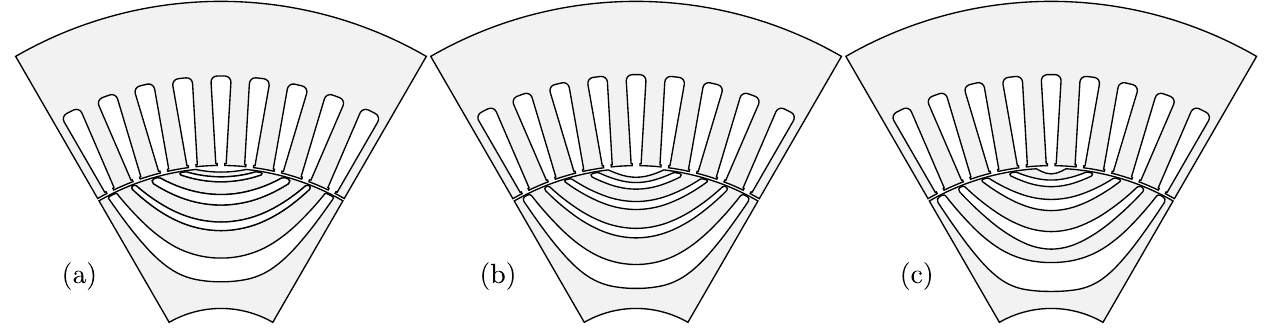
Figure 14. Optimized cross section of three best topologies: ( a ) Zh; ( b ) MZhED; ( c ) MZhVD